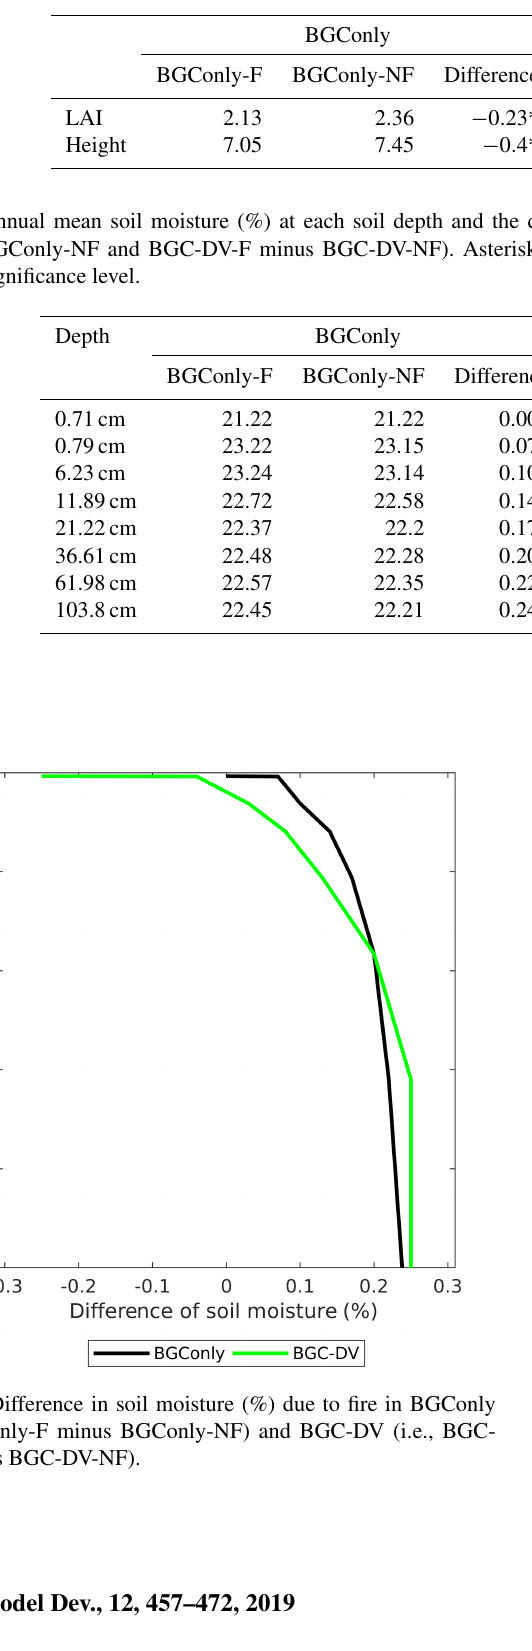
Table 6. Annual mean values for LAI (m 2 m − 2 ) and vegetation height (m) and the difference between the one with fire and the one without fire (i.e., BGConly-F minus BGConly-NF and BGC-DV-F minus BGC-DV-NF). Asterisk (*) indicates that the difference passed the Student’s t test at the α = 0 . 05 significance level.